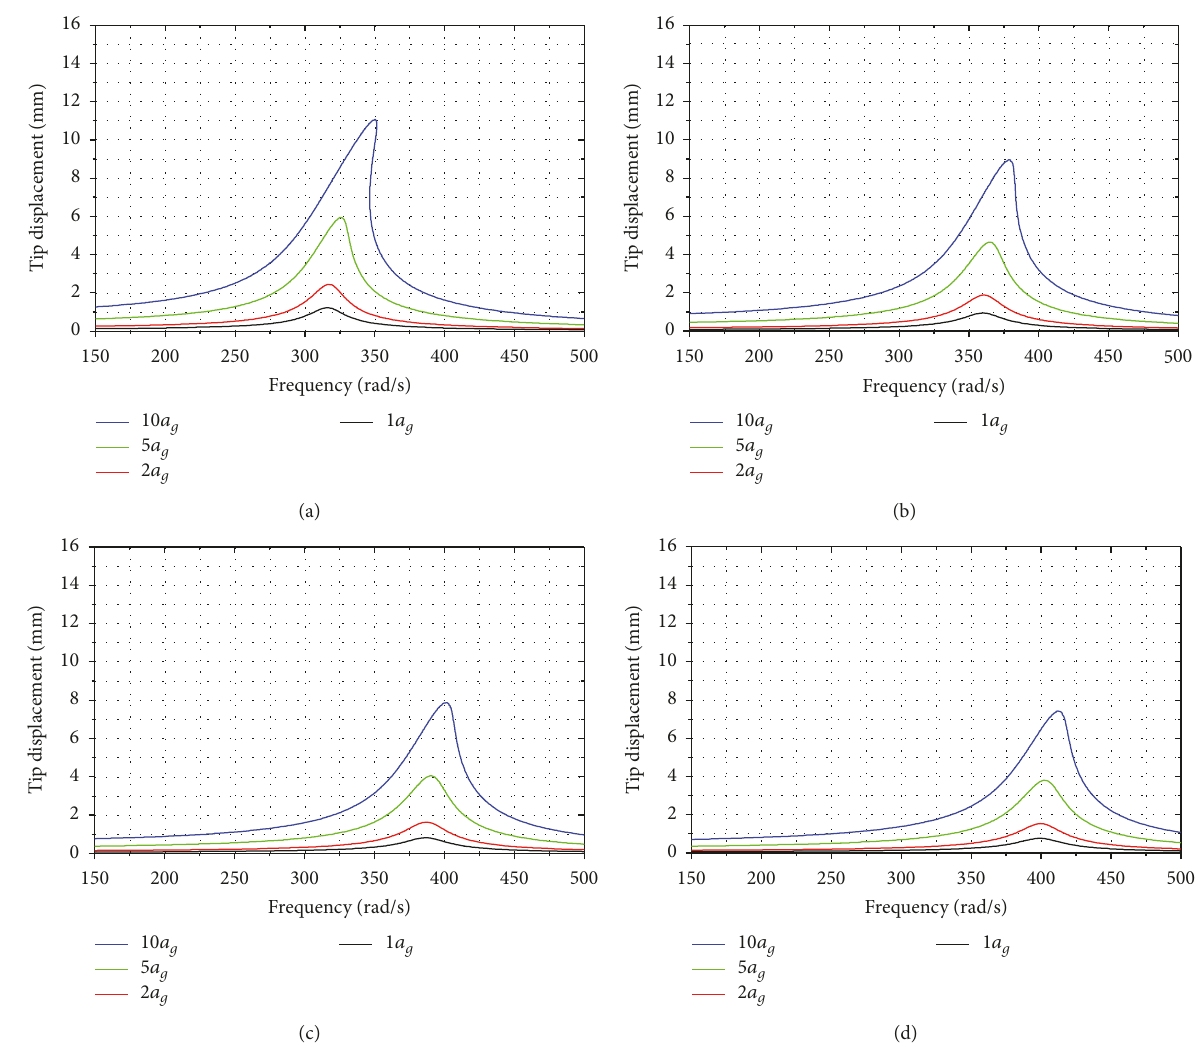
Figure 9: FRFs of the maximum tip displacement for base acceleration amplitudes ranging from 1 𝑎 𝑔 to 10 𝑎 𝑔 , where (a) 𝐸 PVDF = 𝐸 0 PVDF , (b) 𝐸 𝐸 0 𝐸 𝐸 0 𝐸 𝐸 0 PVDF = 1.2 PVDF = 1.4 PVDF = 1.6 PVDF , (c) PVDF , and (d) PVDF